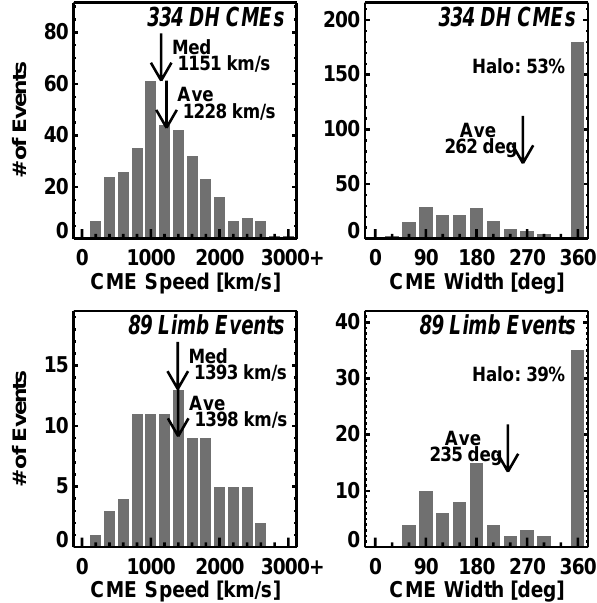
Fig. 3. Speed and width distributions of RL (DH) CMEs, i.e. CMEs associated with type II bursts in the DH wavelength domain. (top) All RL (DH) CMEs and (bottom) limb RL (DH) CMEs, i.e. origi- nating in the central meridian distance range of 60–90 ◦ . The aver- age (Ave) and median (Med) speeds are indicated on the plots. The bin sizes are as in Fig.